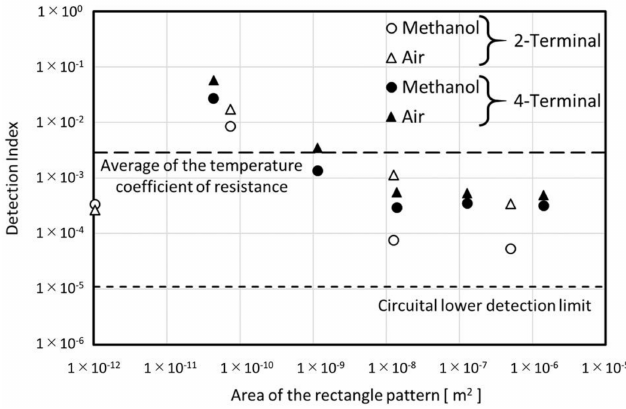
Figure 18. Comparison of the detection index for different rectangle